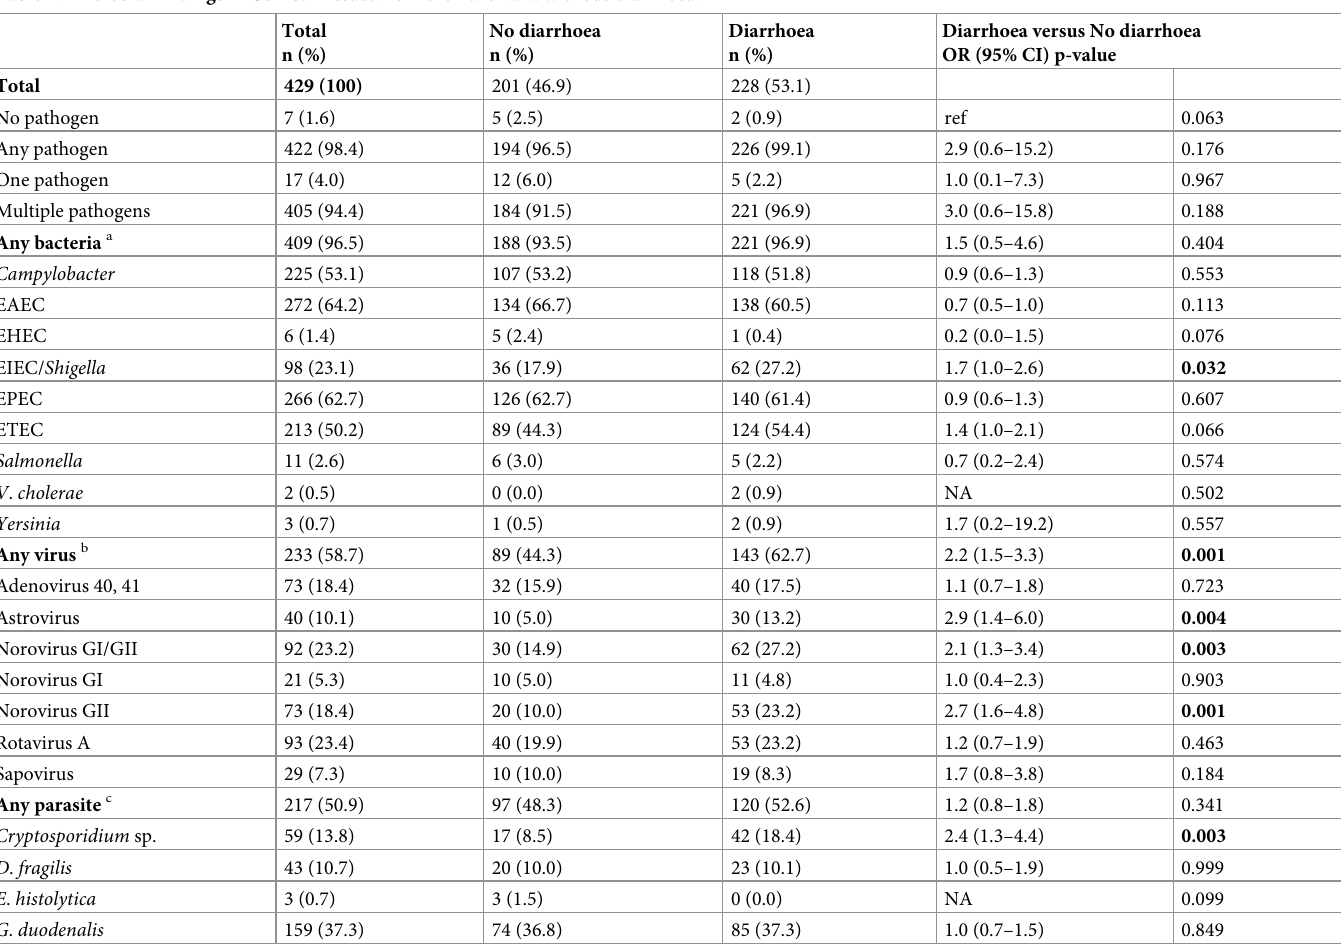
Table 2. Microbial findings in Guinea-Bissauan children with and without